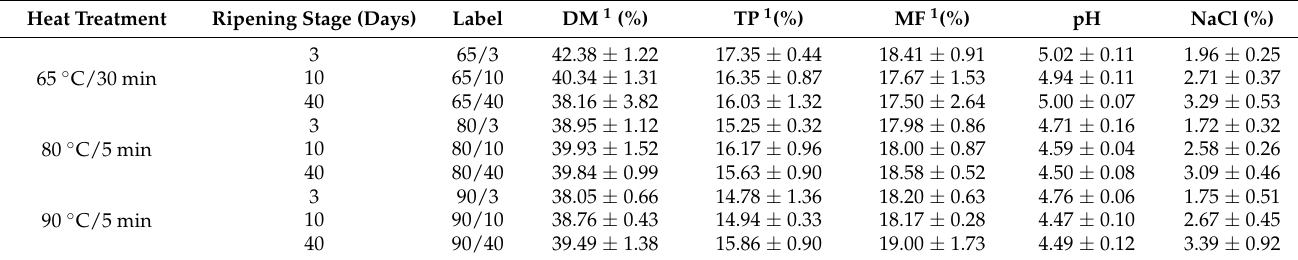
Table 1. Cheeses produced with milk heated to 65 ◦ C/30 min (C), 80 ◦ C/5 min (E1) and 90 ◦ C/5 min (E2), at the early (3 days), mid (10 days) and late (40 days) stage of ripening; Labeling and basic characteristics. Heat Treatment Ripening Stage